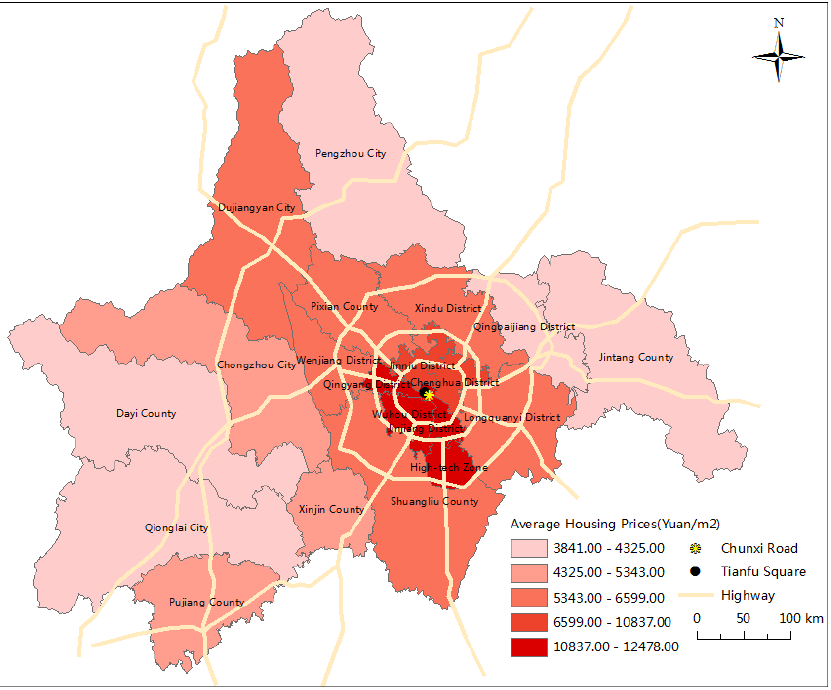
Figure 1. The average housing price pattern in 20 districts of Chengdu in 2016. Data source: Chengdu ReallyDT Platform (www.reallydt.com).